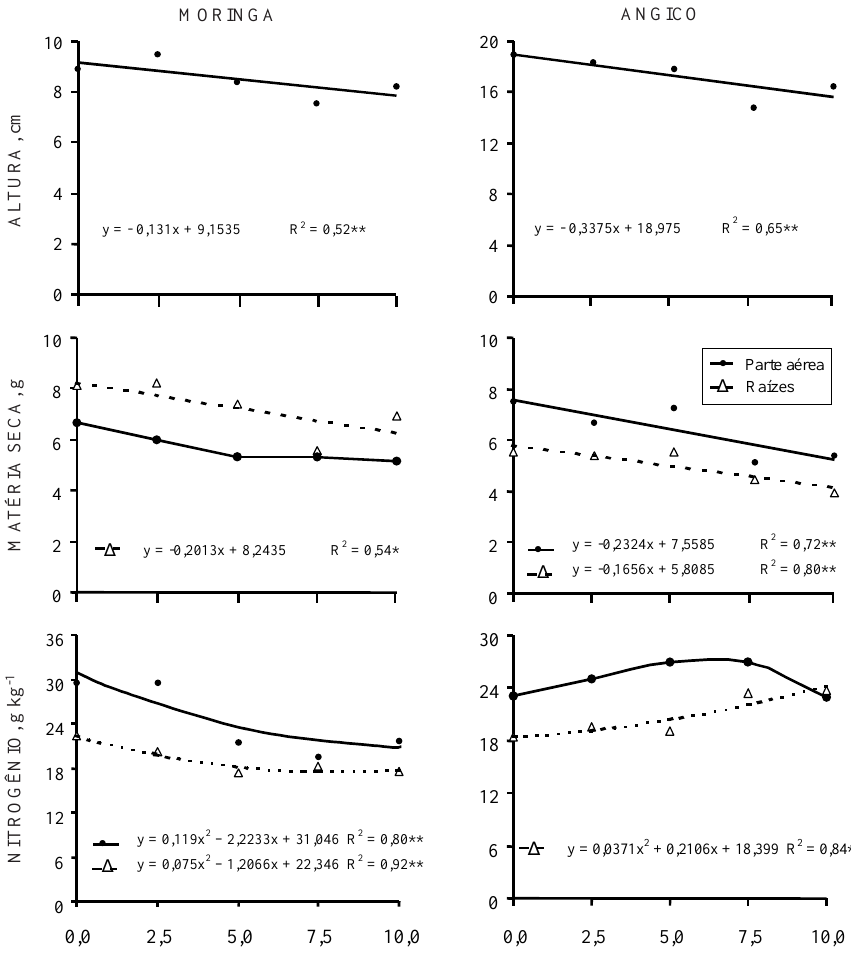
Figura 1. Altura, matéria seca e teor de N da parte aérea e das raízes da Moringa e do Angico em diferentes teores de Al na solução